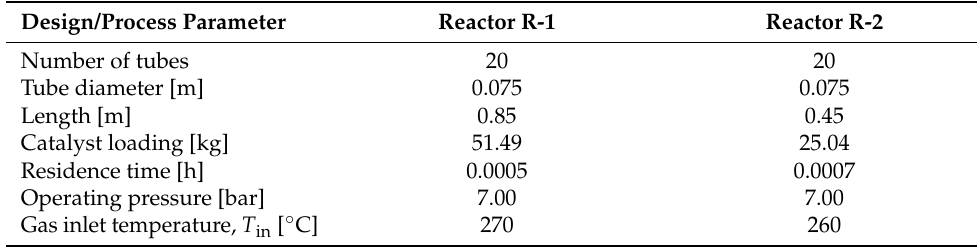
Table 2. Design and process parameters from reactors R-1 and R-2. Design/Process